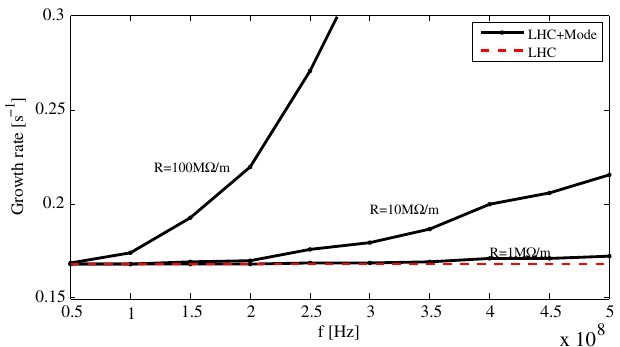
FIG. 17. Most unstable mode growth rate obtained adding on top of the 2016 LHC baseline impedance model an HOM with Q ¼ 20 , variable frequency f and shunt impedance R s . The calculation is done for 2748 nominal LHC bunches of N ¼ 1 . 2 × 10 11 ppb intensity and σ rms ¼ 9 cm bunch length at z b Q 0 ¼ 5 with transverse damper gain of 50 turns. The total number of 8 TCTs is included in the simulations weighting for the betatron function at their